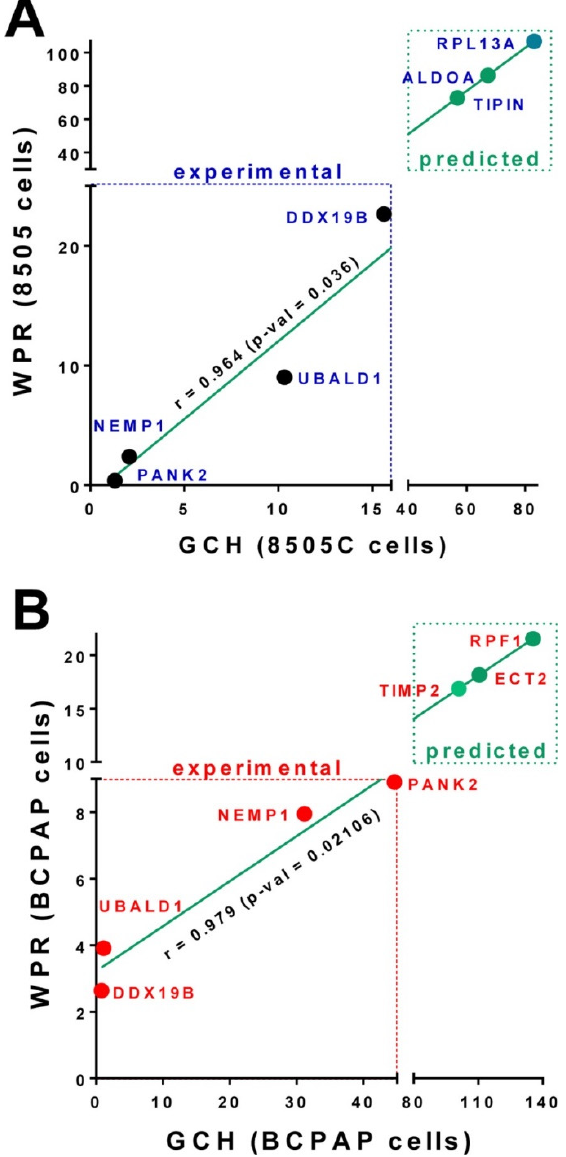
Figure 4. ( A ). Experimentally measured and theoretically predicted effects of stably transfecting PANK2 , NEMP1 , UBALD1 , DDX19B and the top three genes ( RPL13A , ALDOA and TIPIN ) in the 8505C. ( B ). Experimentally measured and theoretically predicted effects of stably transfecting PANK2 , NEMP1 , UBALD1 , DDX19B and the top three genes ( RPF1 , ECT2 and TIMP2 ) in the BCPAP cells.